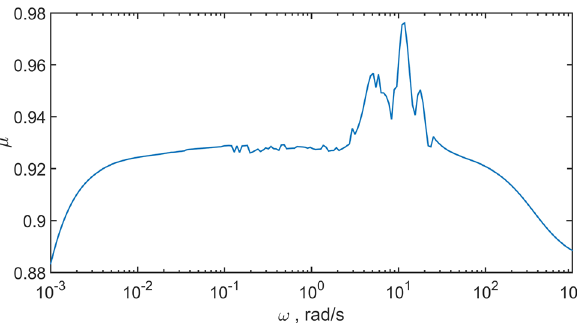
Figure 16: Upper bound on structured singular values.